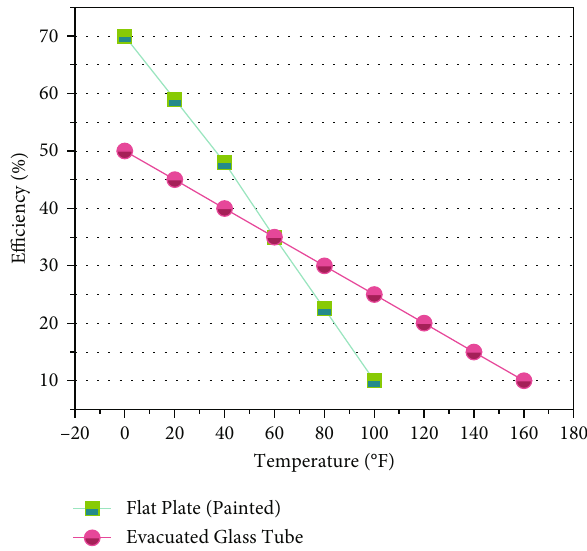
Figure 12: Performance comparison of fl at plat and evacuated glass